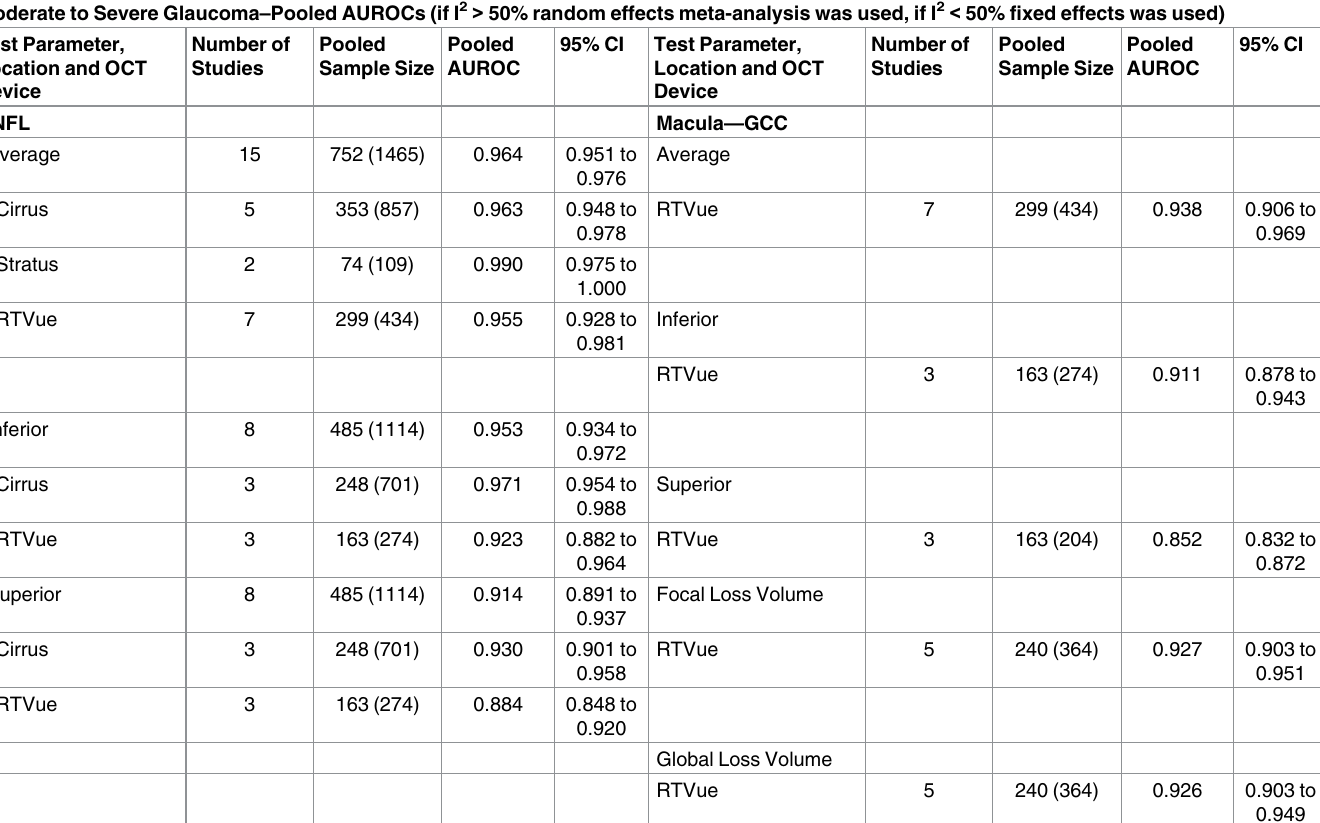
Table 6. Pooled AUROCs of RNFL and macular OCT parameters for moderate to severeglaucoma patients.